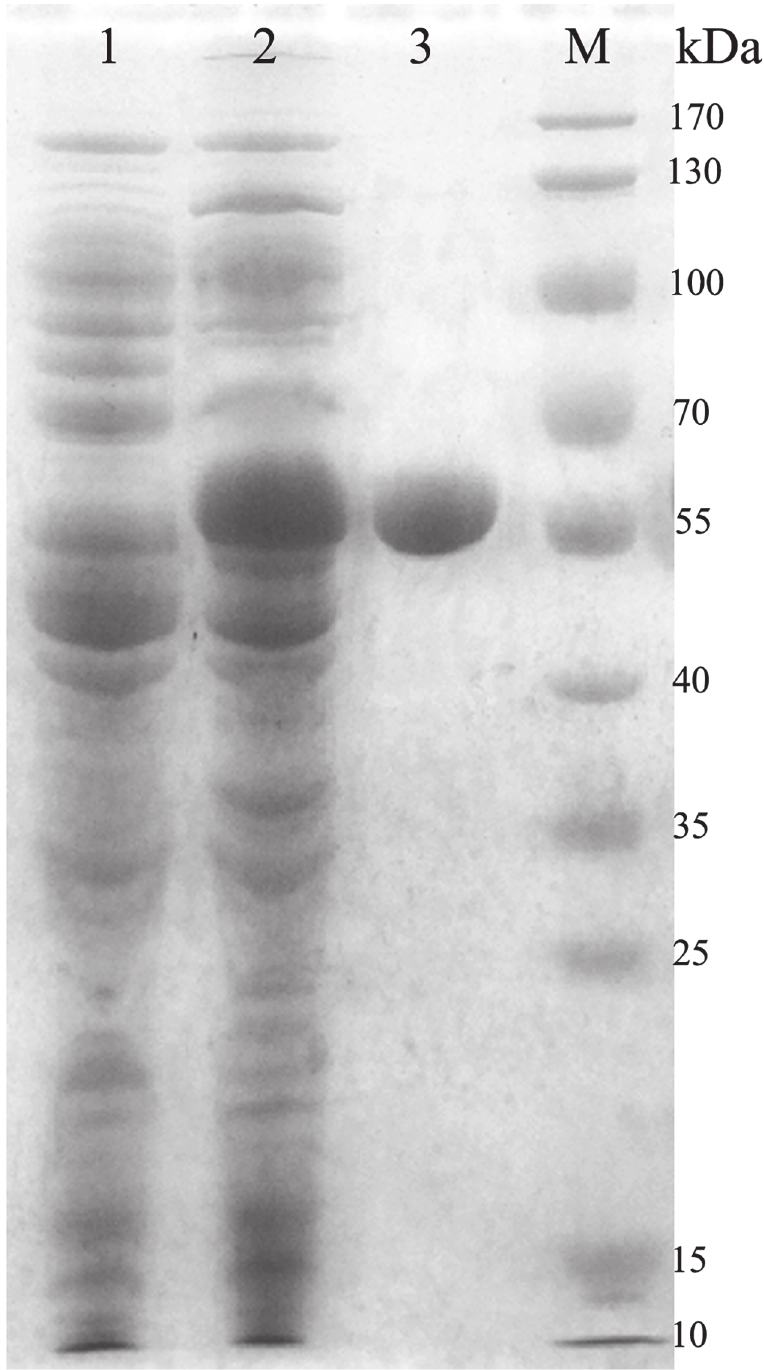
Fig 3. Analysis of the protein expressed in E . coli BL21 cells following purification on a 12% SDS- PAGE. Lane M, protein molecular marker; Lane 1, before induction with 0.7 mM IPTG; Lane 2, after induction with IPTG and grown at 20°C for 20 h; and Lane 3, purified recombinant CarEW ( * 53.76 kDa).